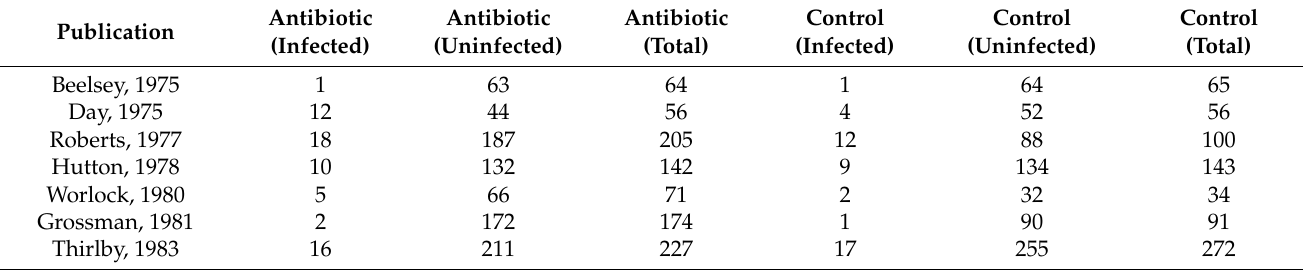
Table 4. Sample Data for Calculation Odds Ratio